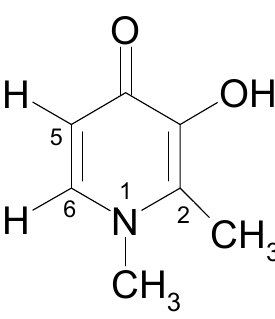
Figure 1. The chemical structure of deferiprone (L1).